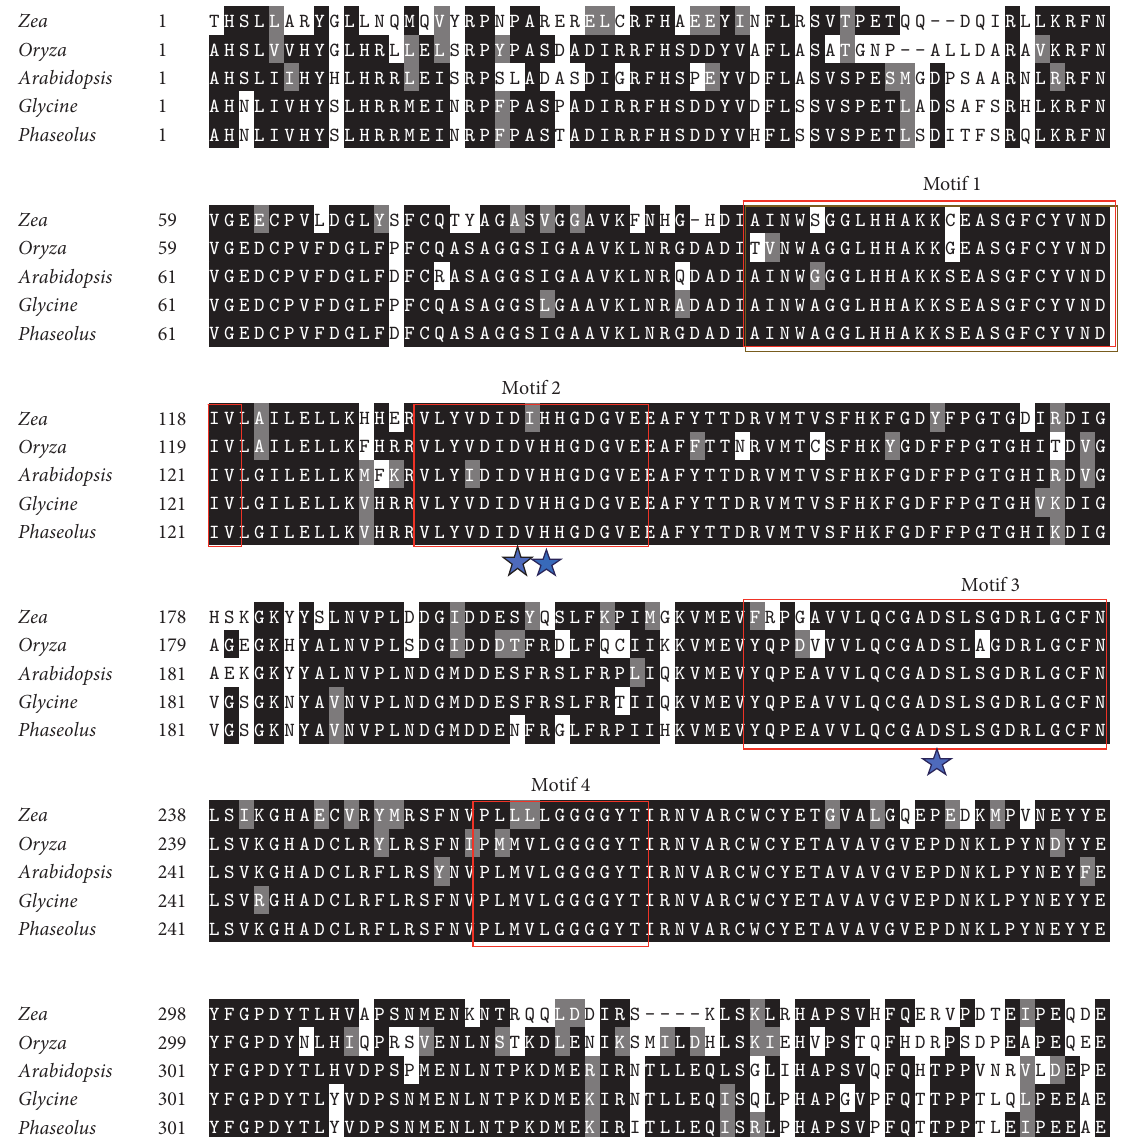
Figure 1: Multiple sequence alignment of putative HDA6 from common bean cultivar Sierra with homologs in model plants. The alignment was generated using CLUSTALW and BOXSHADE and the amino acid sequences of HDA6 in Phaseolus used for the alignment are amino acids from Sierra. Highly conserved regions or identical amino acid regions from the BOXSHADE results are highlighted in black with white letters; gray regions are conserved amino acid substitutions. Four motifs were identified within the protein sequences (Pandey et al. 2002) and the three amino acids with star are conserved in common bean HDA6 as in Arabidopsis HDA5 and they could be responsible for HDAC activity (Luo et al.